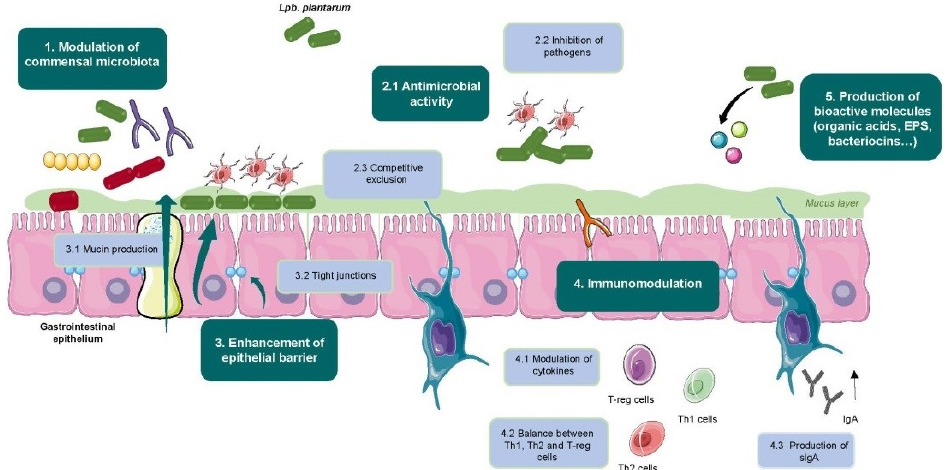
Figure 1. Mechanisms of action of Lpb. plantarum health benefits. Graphical illustrations were created using items from Servier Medical Art by Servier, available at https://smart.servier.com/ under a Creative Commons Attribution 3.0 Unported License.